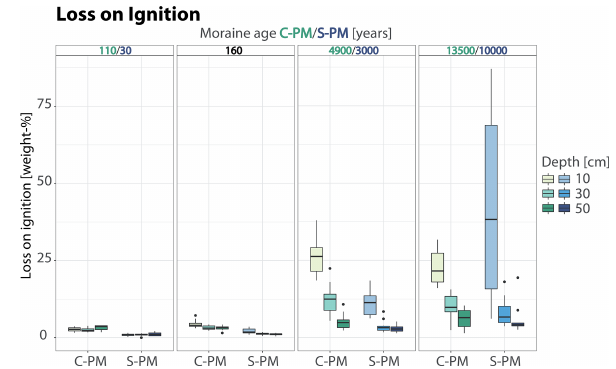
Figure 6. Development of loss on ignition at 10, 30, and 50cm over 10 millennia on silicate (S-PM, shown in blue color scale) and calcareous (C-PM, shown in green color scale) parent